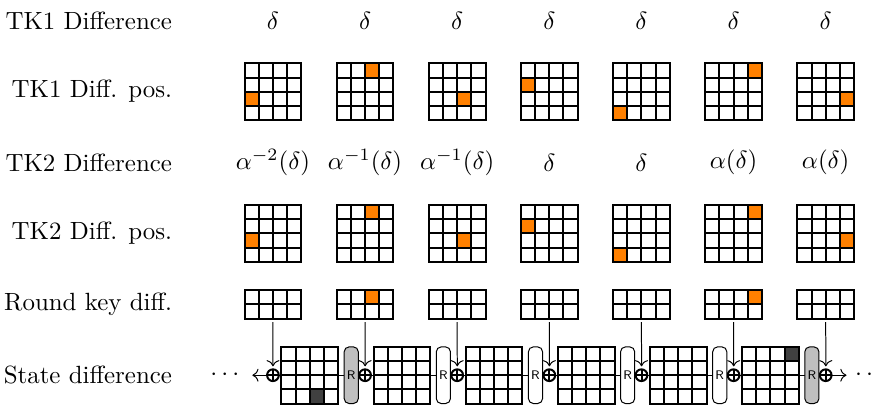
Figure 7: Skinny path construction with two active tweakey